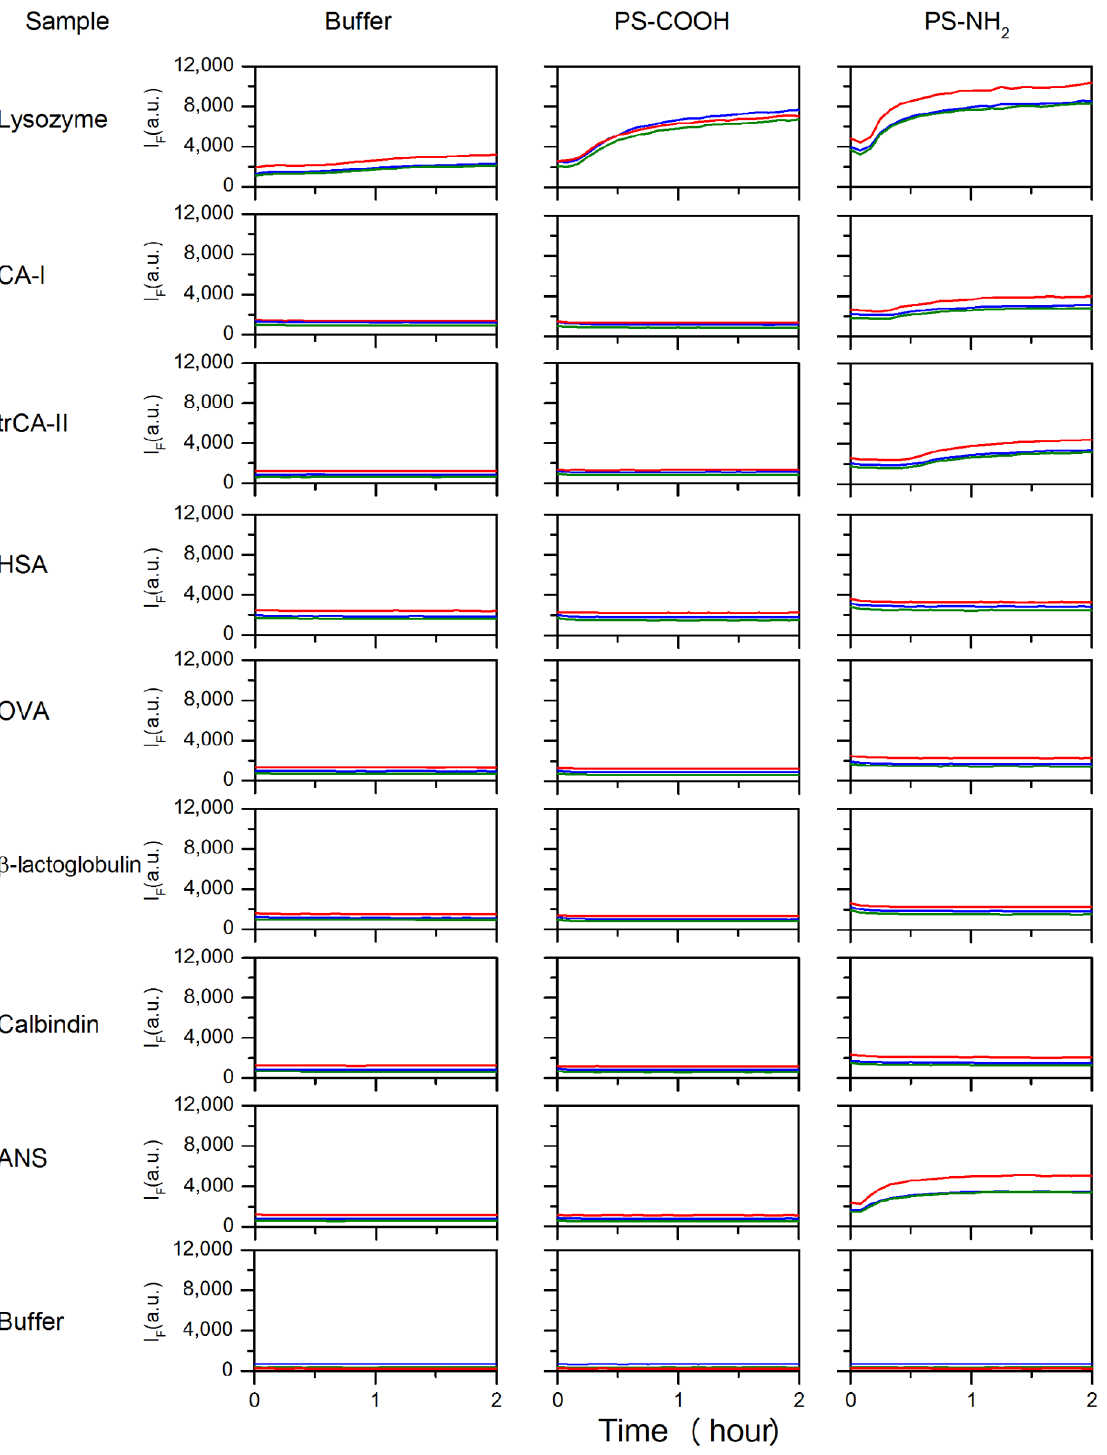
Fig 2. Screening raw data, generated by the plate reader. The interactions between 7 proteins and 2 particles was followed with ANS fluorescence monitored at 3 emission wavelength; blue = 460 nm, green = 475 and red = 520 nm, over time. The shown results are the average of three sample replicates.